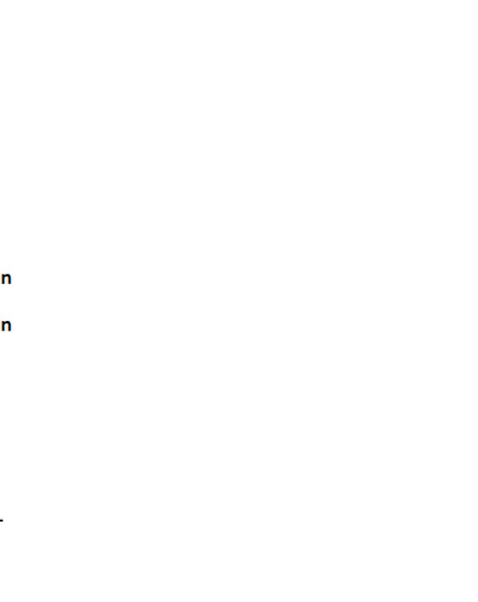
Fig. 3. 3-MA prevents LC3 accumulation and reduces cediranib/quinacrine efficacy. A) Representative LC3 western blots obtained from 4C8 cells grown under hypoxic (0.5% O 2 ) conditions for 24 hrs while exposed to a combination of cediranib (2 m M) and quinacrine (1.5 m M), either with or without 2 mM 3-MA. B) Results from MTS cell viability assays showing mean 4C8 cell viability in response to treatment, normalized to untreated samples. Assays were performed after cells were exposed to treatment for 72 hours, under hypoxic (0.5% O 2 ) conditions. Results are mean ¡ SEM of three independent experiments, performed in triplicate. Significant differences between tumor cell viability results obtained with and without 3-MA are denoted by * (p , 0.05).